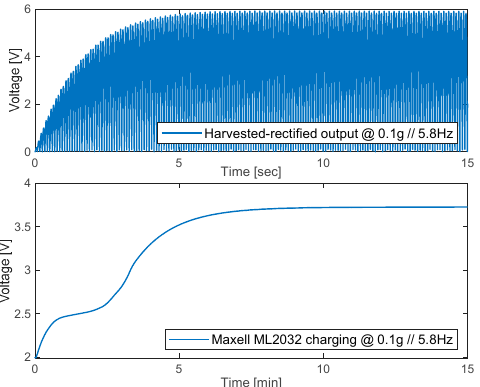
Figure 9. Energy harvesting simulation with sinusoidal base acceleration input ( R b in t = 1 Ohm).